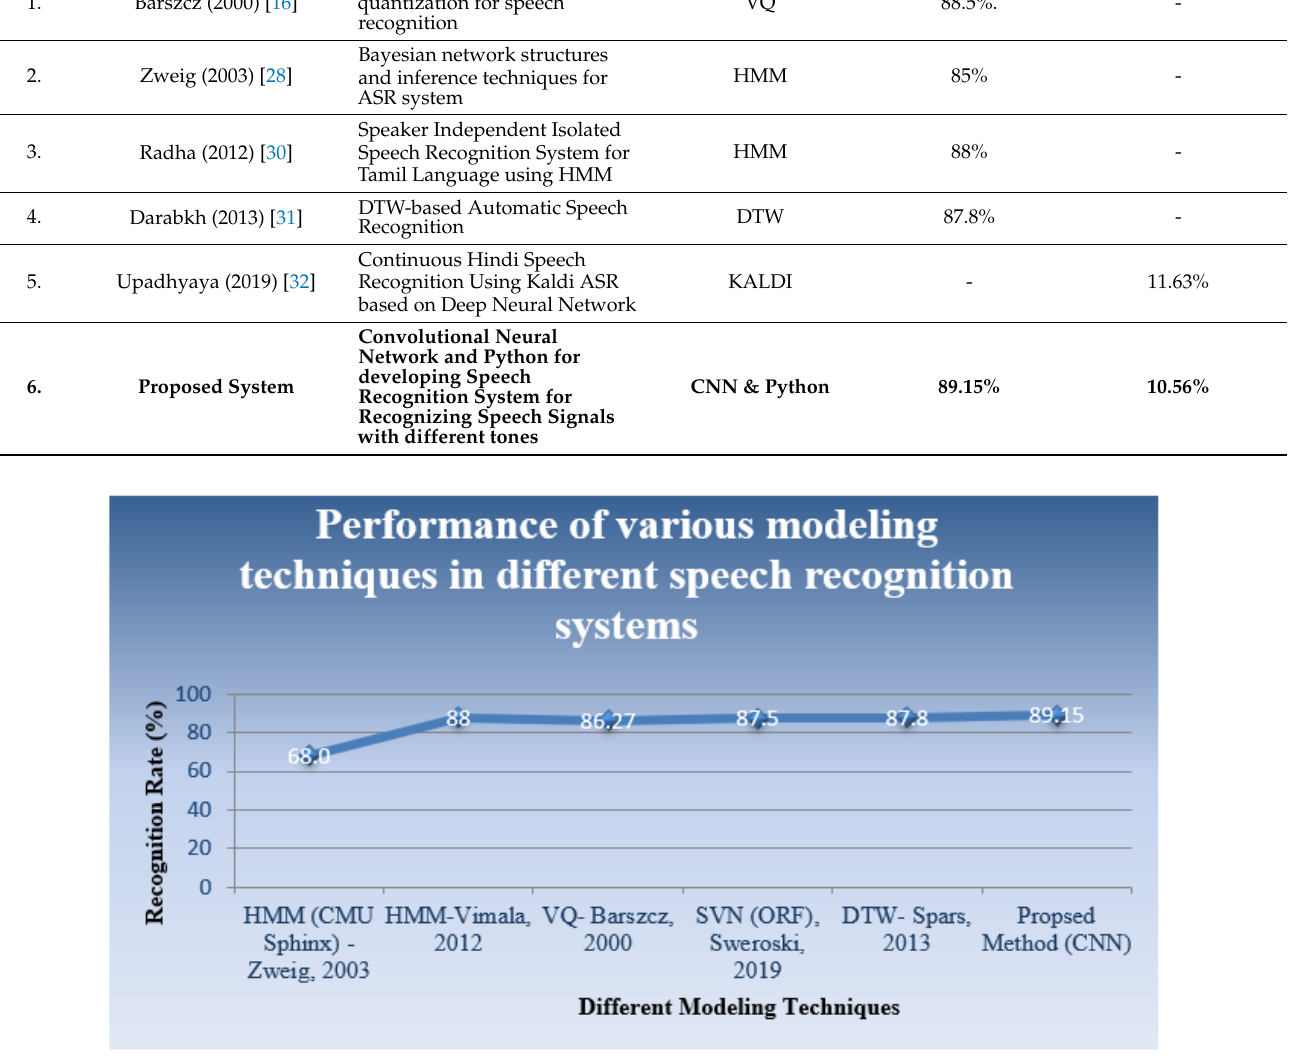
Figure 7. Performance comparison of different techniques [16,18,30–32] with proposed technique